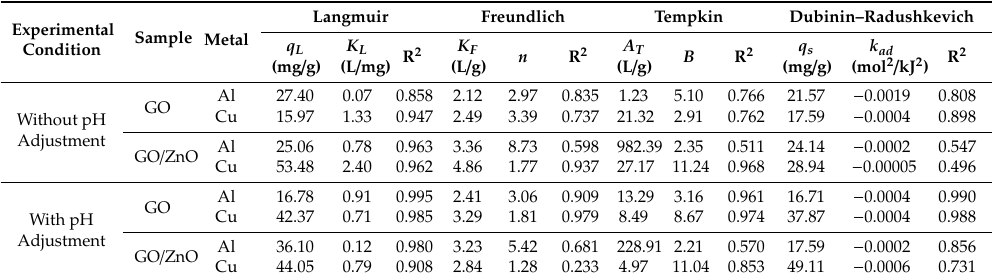
Table 1. Parameters for the Langmuir, Freundlich, Tempkin and Dubinin-Radushkevich isotherm models for experiments with and without pH